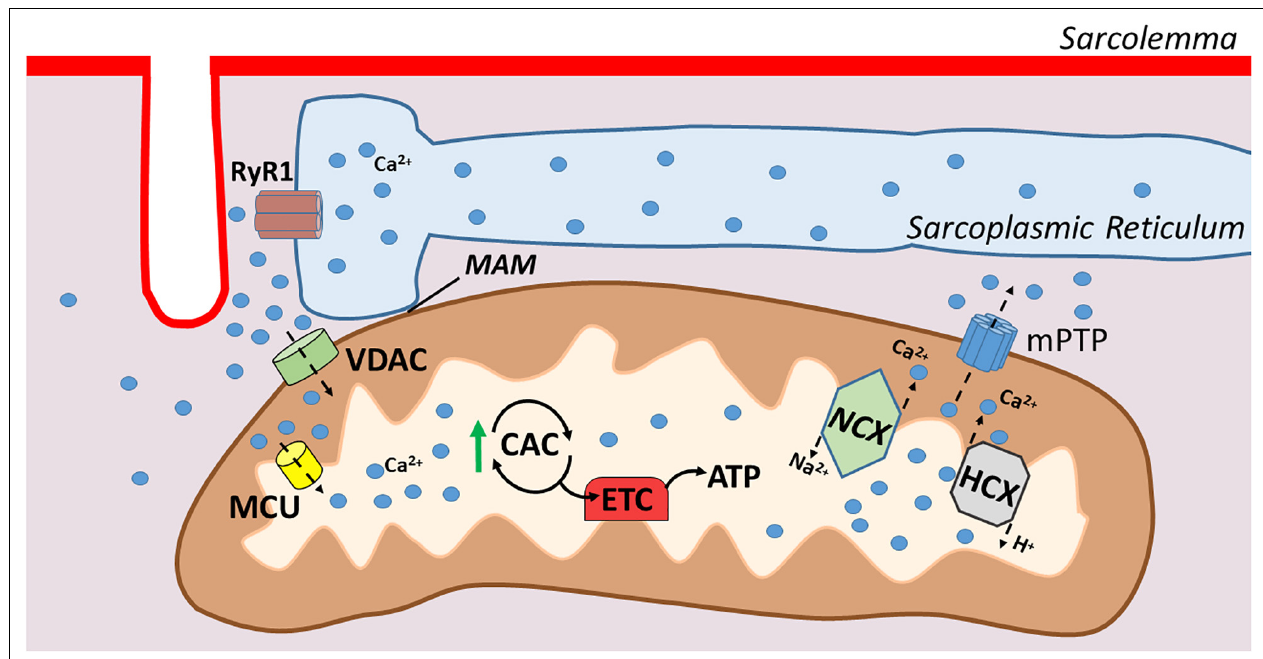
FIGURE 2 | Illustration of mitochondrial calcium transport. Mitochondrial associated membranes (MAMs) result in microdomains of high Ca 2 + levels that facilitate Ca 2 + entry through the outer mitochondrial membrane via voltage dependent anion channel (VDAC). Ca 2 + crosses the inner mitochondrial membrane via the mitochondrial uniporter (MCU), which then stimulates respiration via increases in citric acid cycle enzymes. Ca 2 + is extruded from the mitochondria via Na + /Ca 2 + exchanger (NCX) and H + /Ca 2 + exchanger (HCX) in the inner membrane and the outer membrane via the mitochondrial permeability transition pore (mPTP).